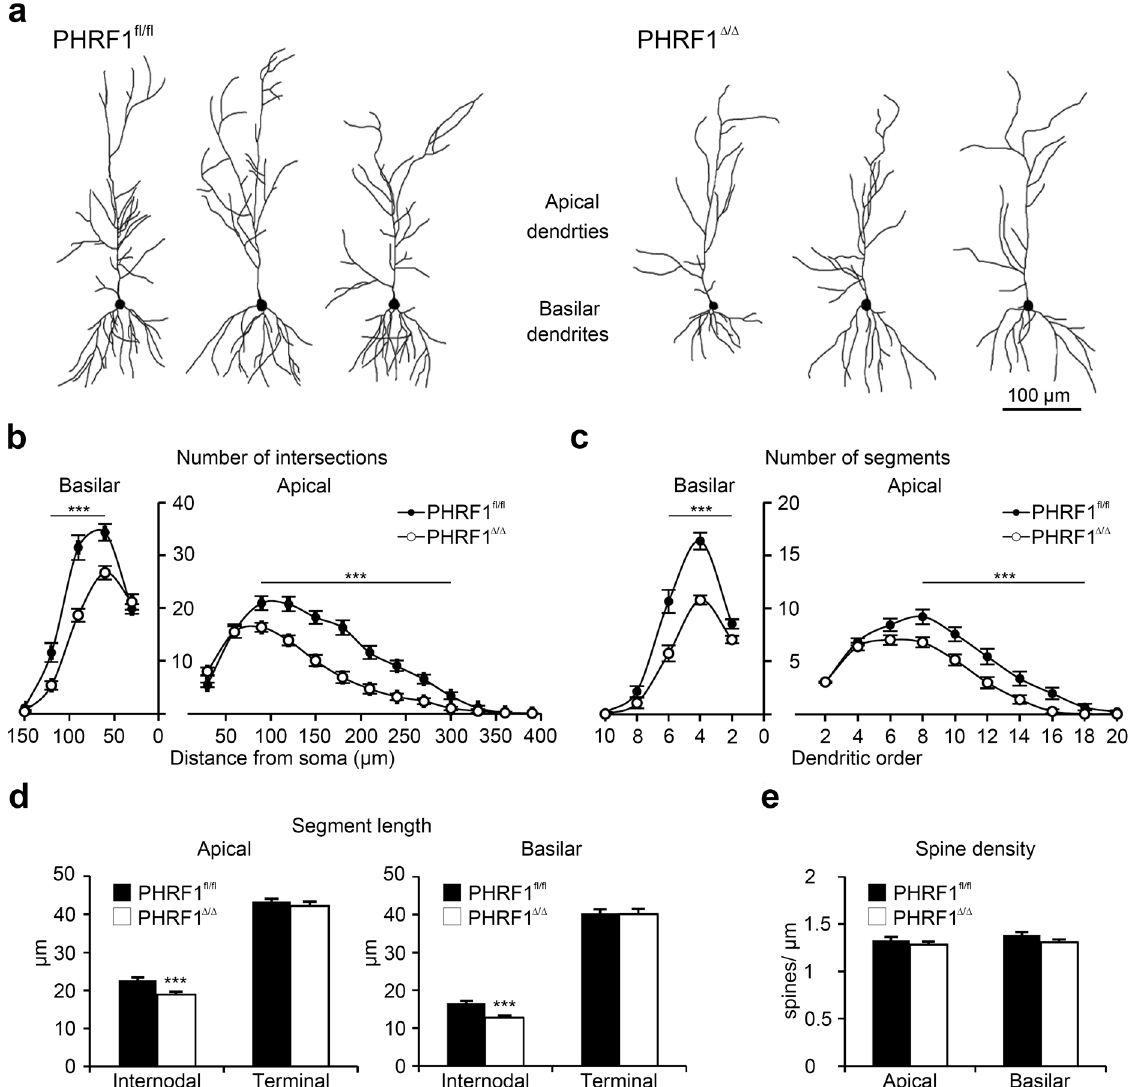
Figure 4. Dendritic architectures of CA1 pyramidal neurons. ( a ) Examples of reconstructed CA1 pyramidal neurons from both genotypes. ( b , c ) Dendritic complexity was assessed by Sholl analysis and the number of segments of each dendritic order. ( d ) The length of internodal and terminal dendritic segments. ( e ) Density of dendritic spines. n ≧ 30 neurons from 7 mice for each genotype. Data are mean ± SEM. *p < 0.05, **p < 0.01, ***p < 0.001, two-tailed unpaired Student t-test.